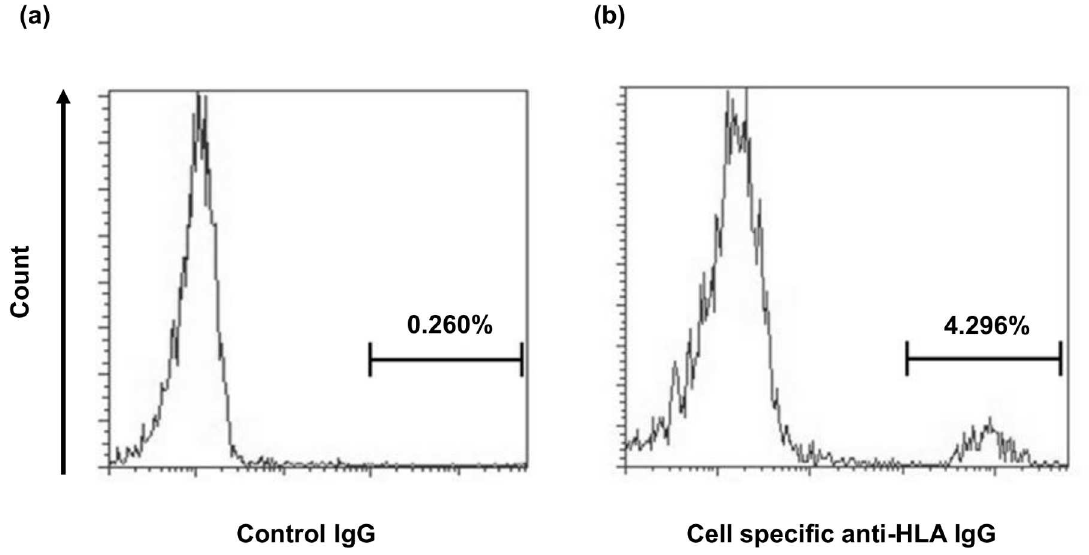
Fig 4. Surface expressionof HSP90 α was enhancedby bindingof the anti-HLA antibody. Humanaorticendothelial cells were incubated withinthe specific anti-HLAIgG or nonspecificIgG.Afterincubation,the cells were stainedwith FITC- labeledgeldanamycin and analyzed. Flow cytometry shows increased expression of geldanamycin-positive cells with anti- HLA IgG ligation(b, 4.296%)versus control IgG (a, 0.460%). This experimentwas independently performedthreetimesand the resultsobtainedwere substantiallythe